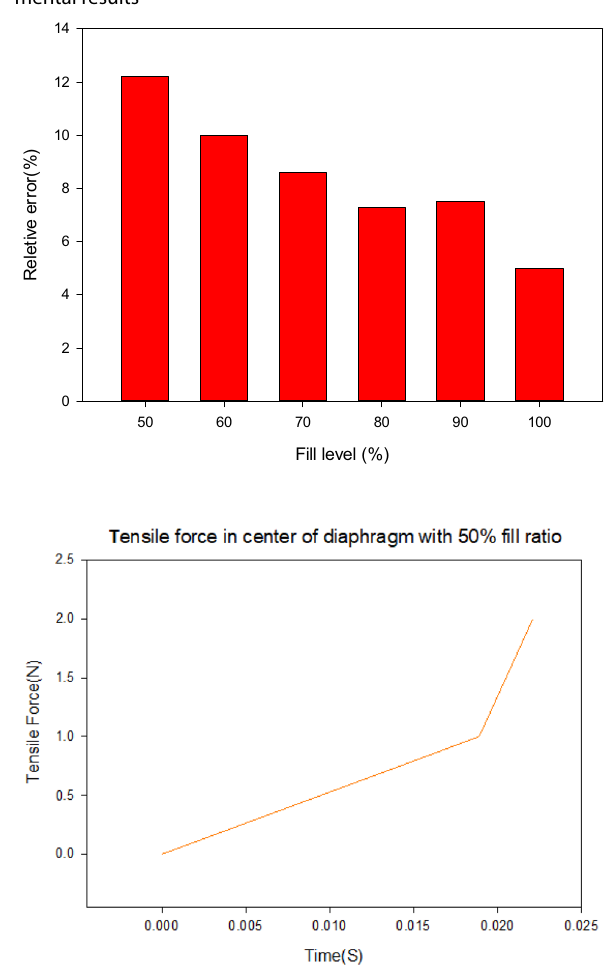
Table 5 The amount of difference between numerical and experi- mental results